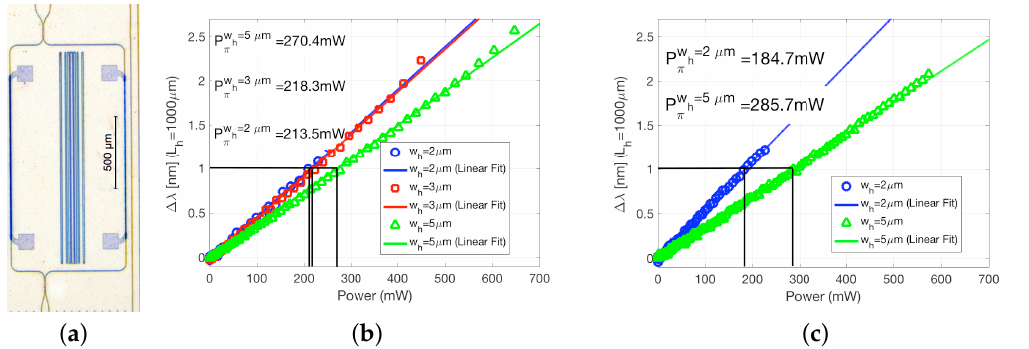
Figure 8. ( a ) Mach-Zehnder Interferometer (MZI) test structure for thermal-tuners, performance of tuners based on a metal layer stack of ( b ) 100 nm Au and 30 nm Cr and ( c ) 30 nm Au, 15 nm Ni, 10 nm Ti. Abbreviations: ∆ λ is the wavelength shift in the MZI spectrum due to the actuation of the heater; P w h π is the π shift power for a given heater width, w h